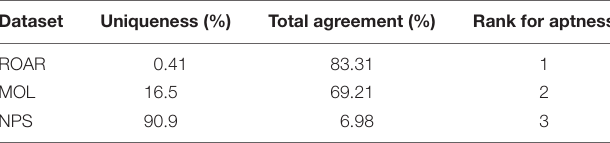
TABLE 3 | Aptness Component